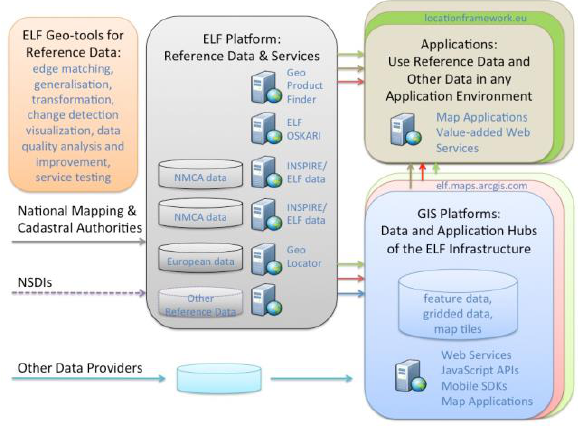
Figure 1. The ELF Platform and Elements of ELF